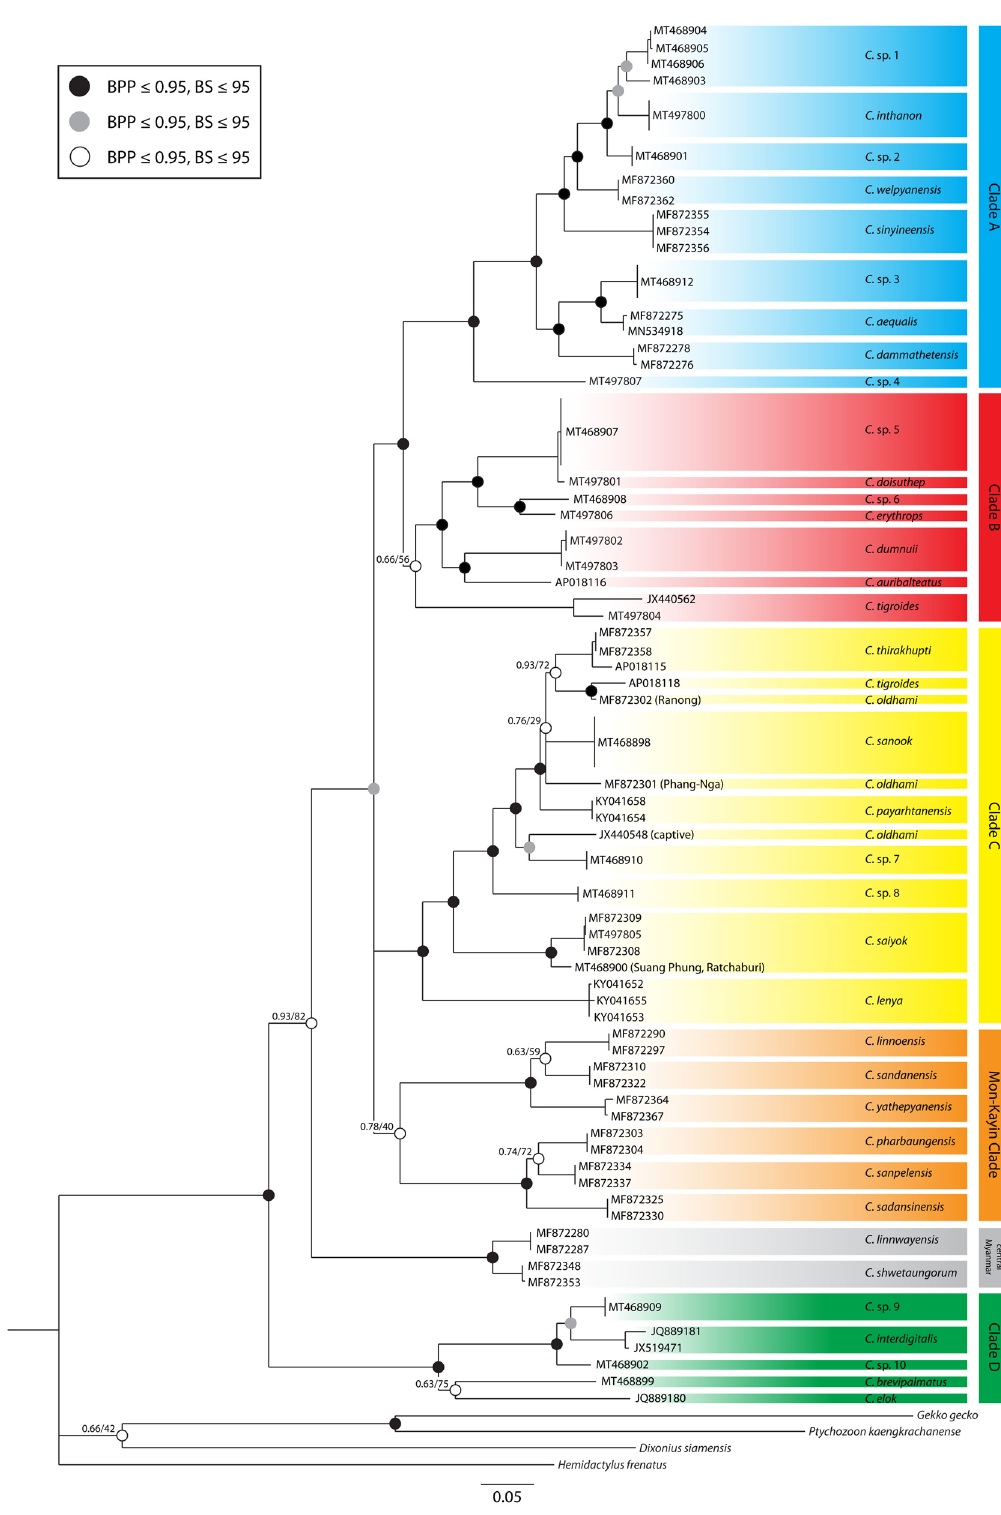
Figure 2. Phylogenetic relationship among geckos in the genus Cyrtodactylus distributed in northern and western Thailand based on the mitochondrial ND2 gene with flanking tRNA sequences. Values near the nodes represented Bayesian posterior probability (BPP) and ML bootstrap support values (BS, 1,000 replicates) as BPP and BS,